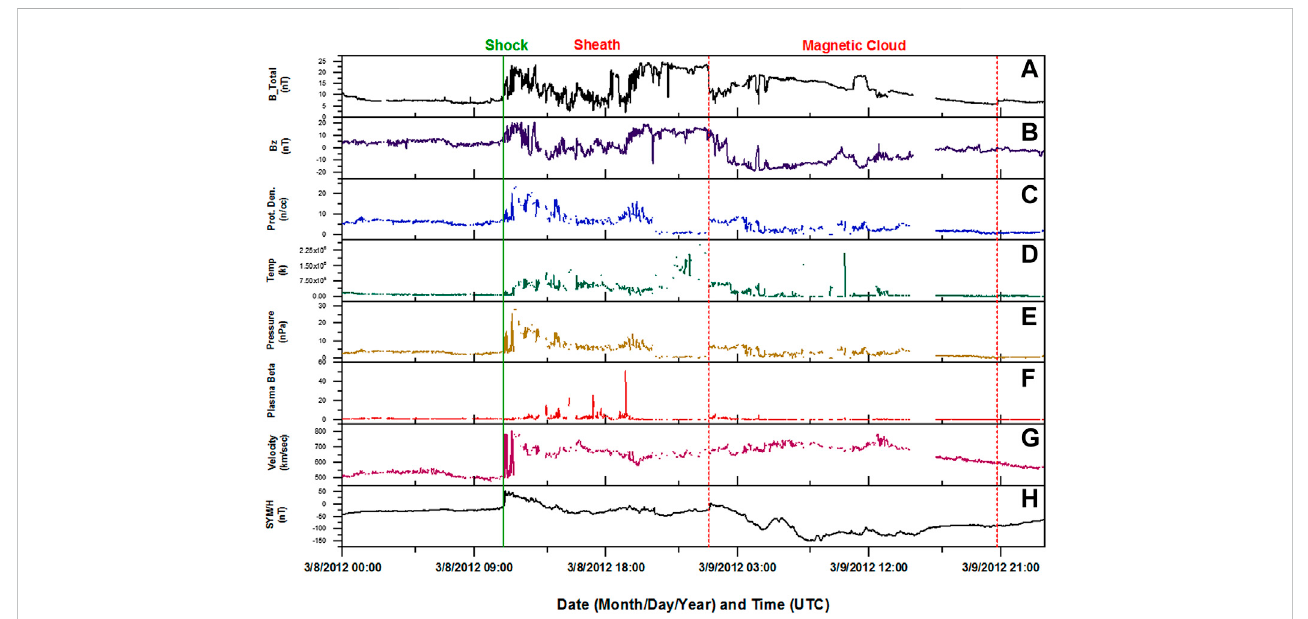
FIGURE 8 IP shock and ICME signatures at the Sun – Earth L1 point. The panels are (top to bottom) the total magnetic fi eld (A) , Bz component of the magnetic fi eld (B) , proton density (C) , temperature (D) , fl ow pressure (E) , plasma beta (F) , and solar wind velocity (G) . Sym-H variation is shown in (H) . The green and red dotted lines show the arrival of the shock and magnetic cloud of the ICME,